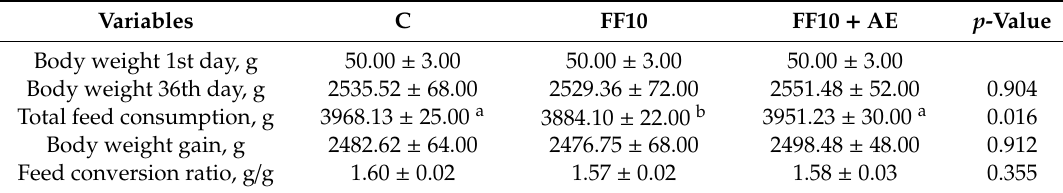
Table 4. The results of broiler production parameters (means ±